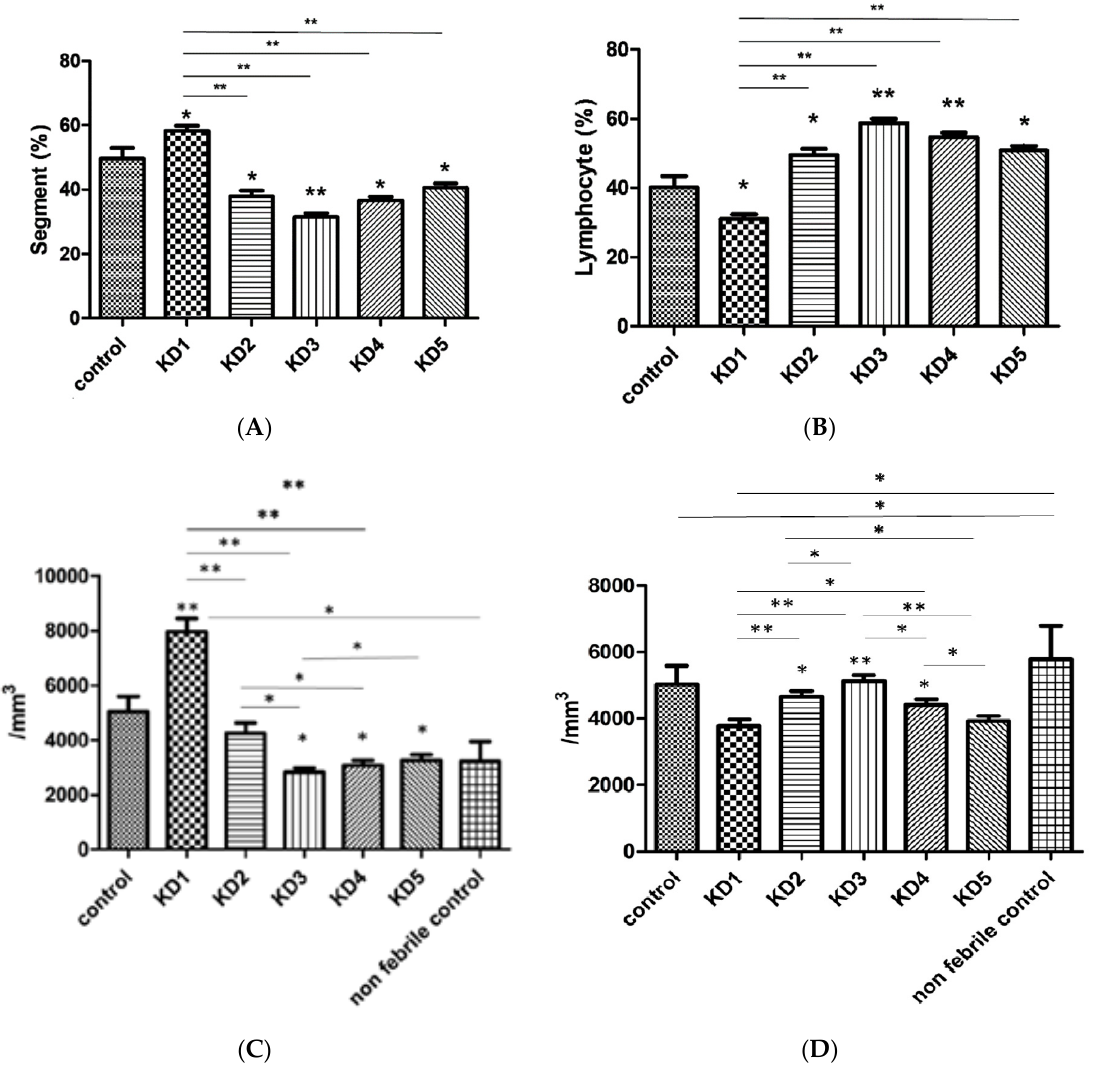
Figure 5. Patients treated with intravenous immunoglobulin (IVIG) developed the lowest significant decrease in percentage of segmented neutrophils and an increase in the percentage of lymphocytes by the third week. ( A ) Segmented neutrophils were statistically significantly higher in the KD group compared with controls and decreased after receiving immunoglobulin for more than one year. ( B ) The percentage of lymphocytes was significantly lower in the KD group than in the control group, increasing after receiving immunoglobulin, and the increase lasted for more than one year. Asterisks denote significance compared with controls. ( C ) Absolute neutrophil counts. ( D ) Absolute lymphocyte counts. KD1, within 24 h prior to IVIG treatment; KD2, 3 − 7 days after IVIG; KD3, three weeks after IVIG, KD4, six months after IVIG; KD5, one year after IVIG. * p < 0.05, ** p < 0.001.